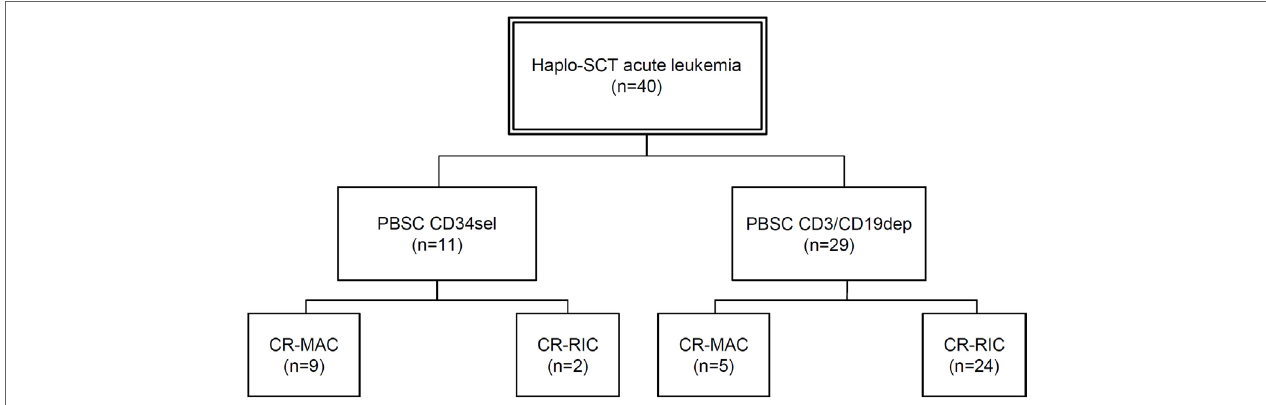
FigUre 1 | Flow chart with patient classification. Abbreviations: Haplo-SCT, haploidentical stem cell transplantation; PBSC, peripheral blood stem cells; CD34sel, CD34 + selection; CD3/CD19dep, CD3/CD19 + depletion; CR, complete remission; MAC, myeloablative conditioning; RIC, reduced-intensity